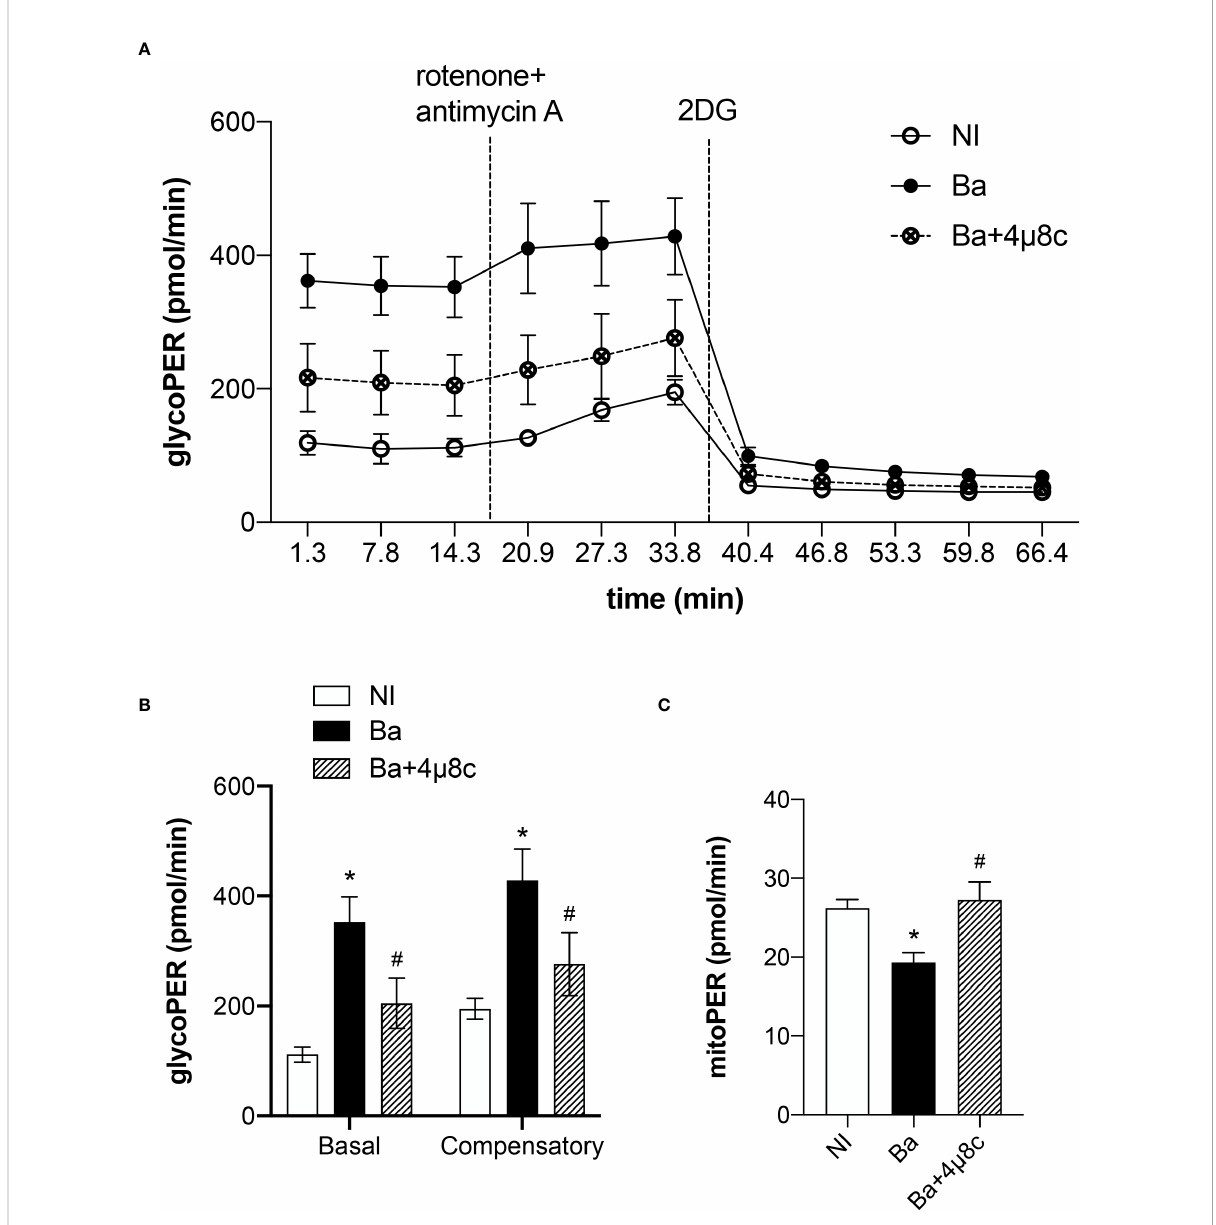
FIGURE 3 IRE1 a regulates the metabolic function of infected macrophages. (A) Time-course quanti fi cation of glycolytic proton ef fl ux rate (glycoPER) in macrophages from C57BL/6 mice non-infected (NI), infected with B abortus (Ba) or pre-treated with 4 m 8c (50 m M) and infected with ( B abortus (Ba+4 m 8c). (B) Quanti fi cation of basal and compensatory glycoPER. (C) Quanti fi cation of mitoPER. The data are representative of three independent experiments. The data (B, C) are presented as mean ± SD, * p < 0.05, one-way ANOVA. * p < 0.05, compared to NI and # p < 0.05, compared to Ba, one-way